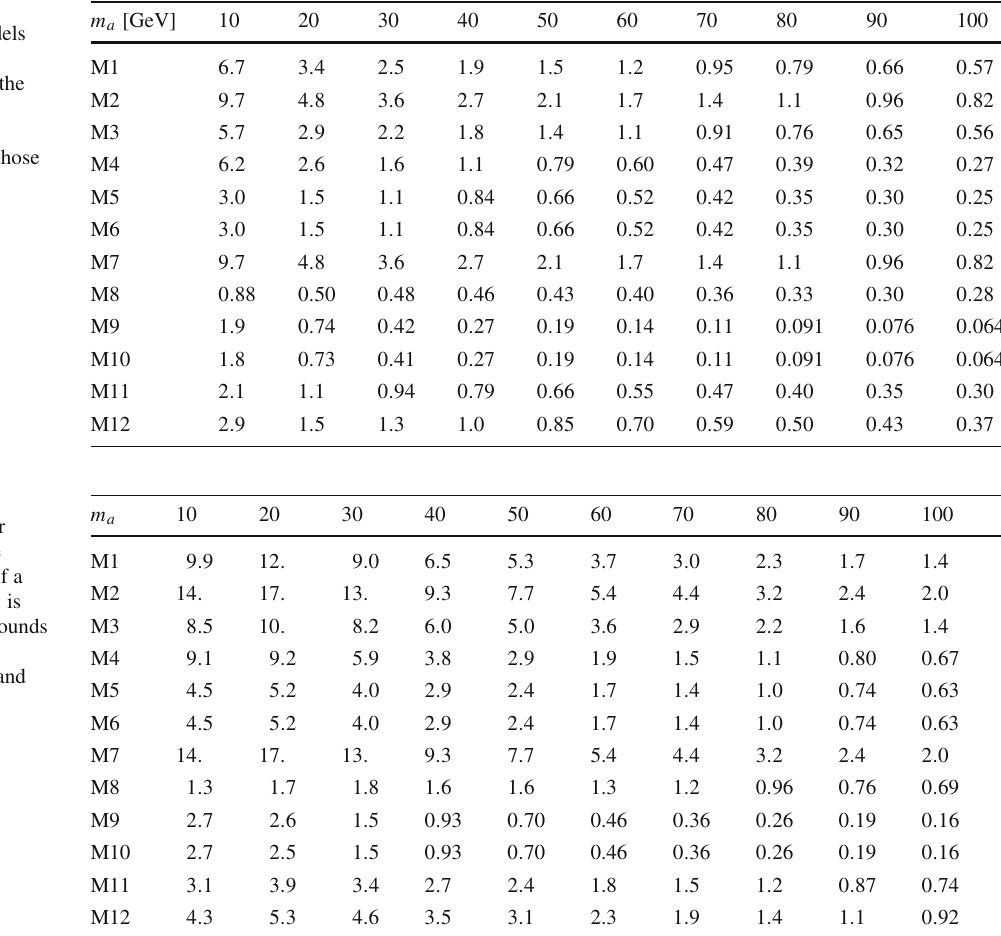
× BR ττ for the models g , eff M1 - M12 and m a = 10 ··· 100 GeV. For the values given, we chose the discrete charges of the top partners to be the same as those of the other fermions